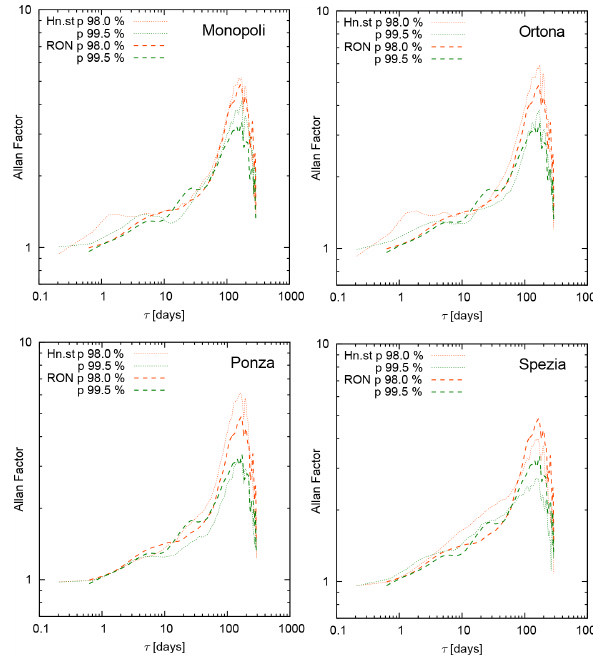
Figure 5. Comparison of Allan factor between RON and hindcast data series for different threshold percentiles (98 and 99.5%).